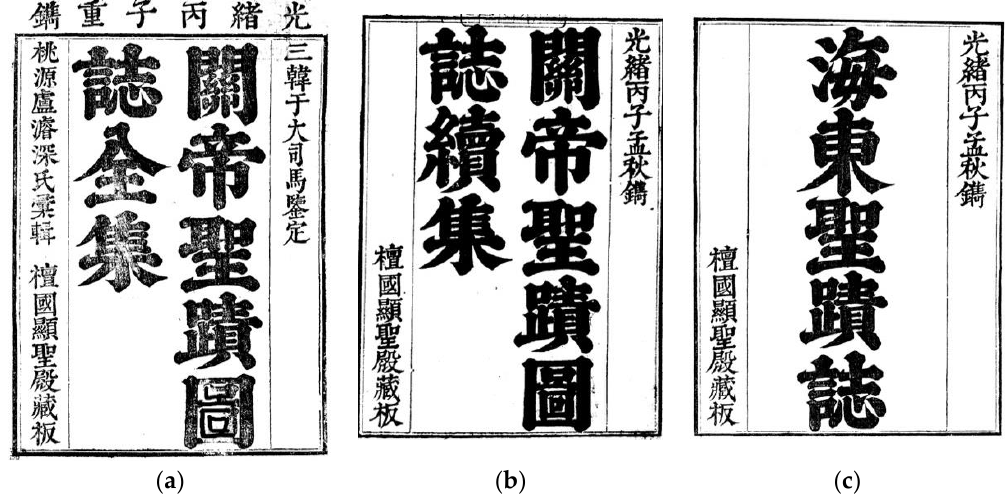
Figure 1. Publication of Guandi Texts in 1876. ( a ) Complete Collection of Illustrated Records of Sacred Achievements of the Thearch Lord Sage Kwan ; ( b ) Continuation of the Illustrated Records of Sacred Achievements of the Thearch Lord Sage Kwan ; ( c ) Records of Sacred Achievements in the East of Sea